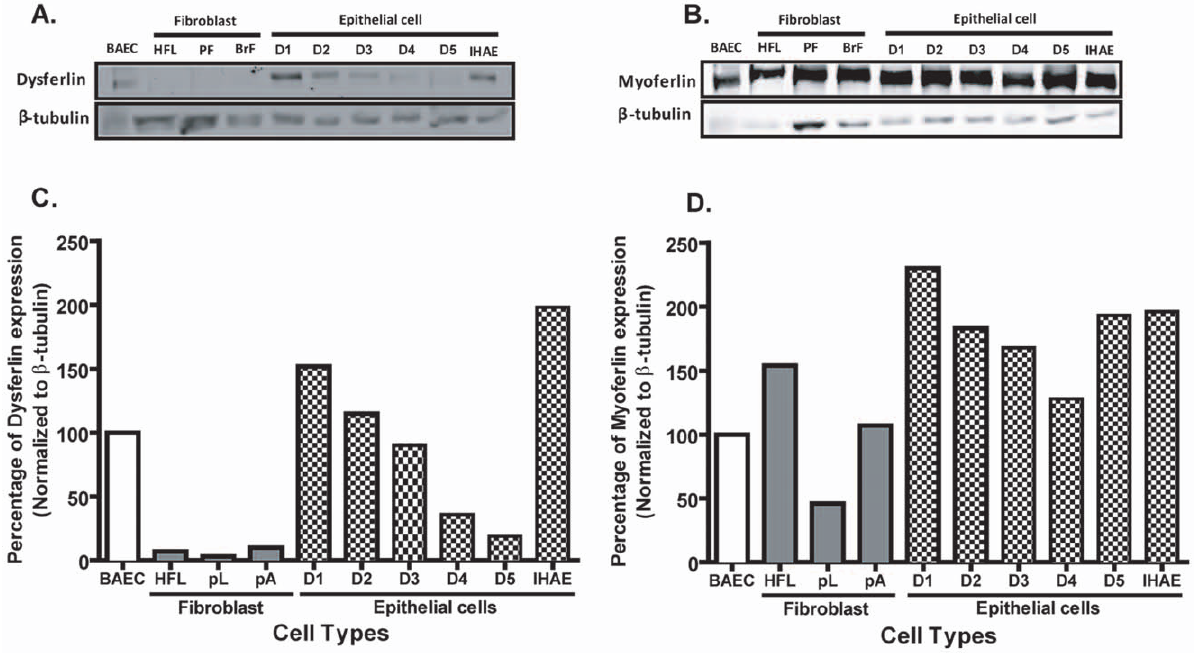
Figure 2. Dysferlin and myoferlin expression in human airway epithelial cells and fibroblasts. Total cell lysates from primary human lung parenchymal fibroblasts (PF), bronchial fibroblast (BrF), airway epithelial cells derived from normal donor lung tissues (D1–D5), bovine aortic endothelial cell (BAEC), human fetal lung fibroblasts (HFL) and bronchial epithelial cell (16HBE) lines were analyzed for the expression of (A) dysferlin and (B) myoferlin by immunoblot. The band intensity of (C) dysferlin and (D) myoferlin was normalized to b -tubulin and compared to BAEC to quantify the expression levels of the ferlin proteins by densitometry.